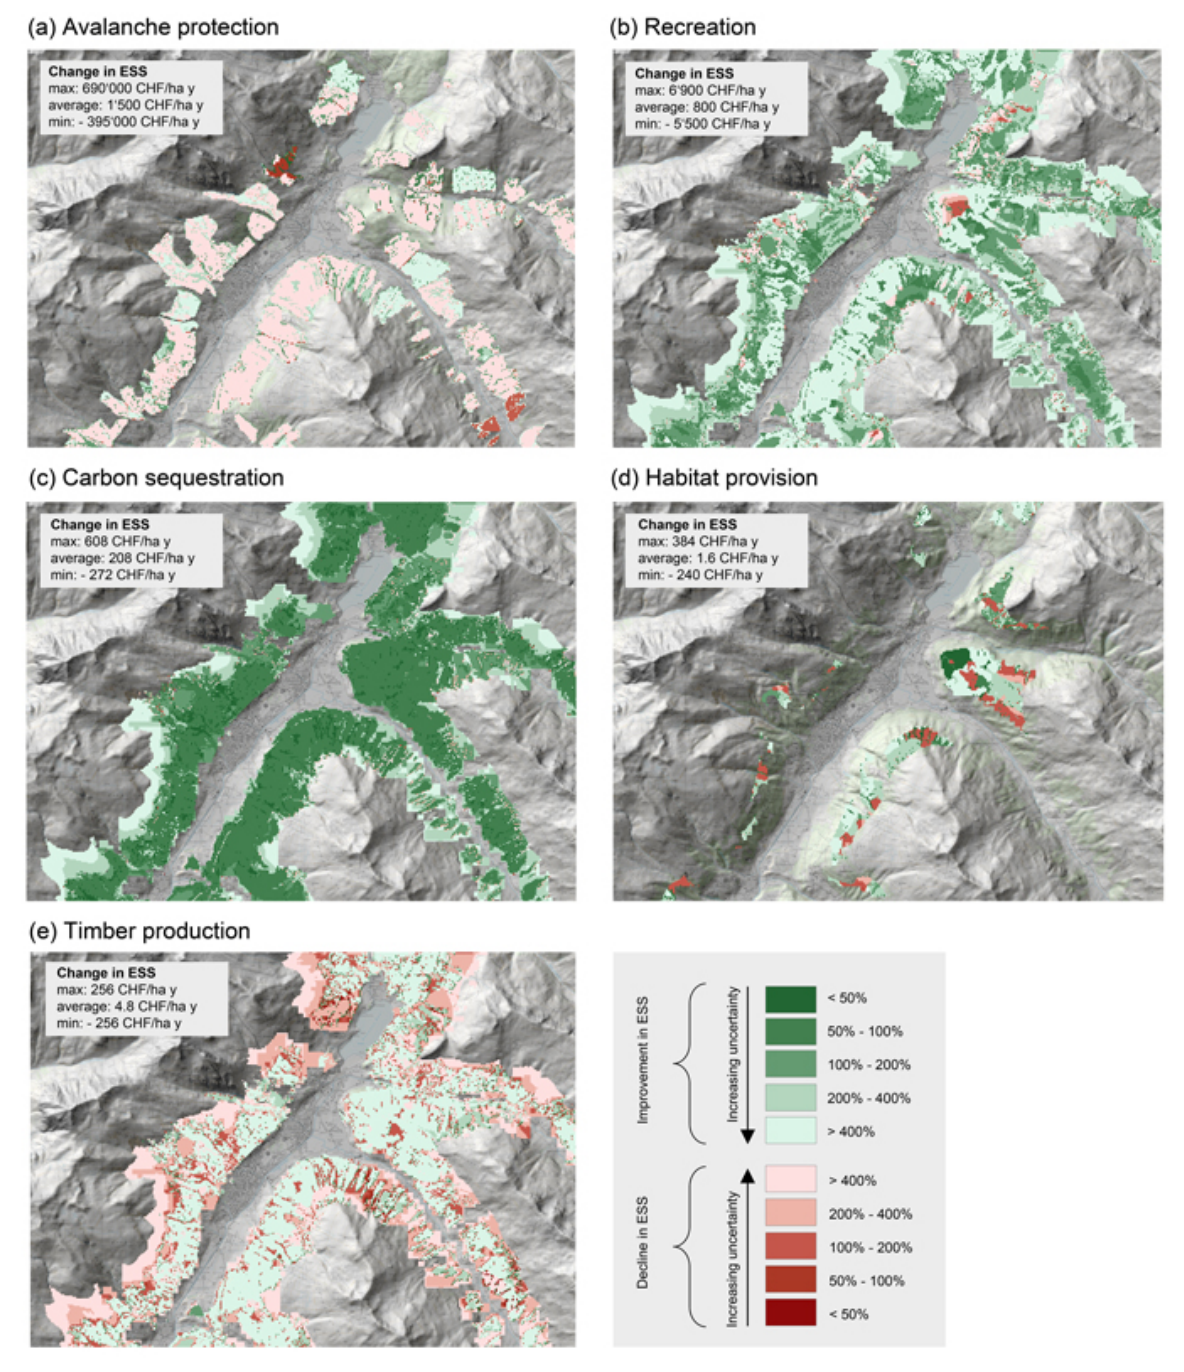
Fig. 4 . Uncertainty maps of forest ecosystem services (ESS) values. Green areas show an increase in ecosystem services values between 2000 and a trend scenario in 2050. Red areas show a decrease in values since 2000 under a trend scenario. The transparency indicates the magnitude of the uncertainties related to the difference in expected values between 2000 and 2050 in each